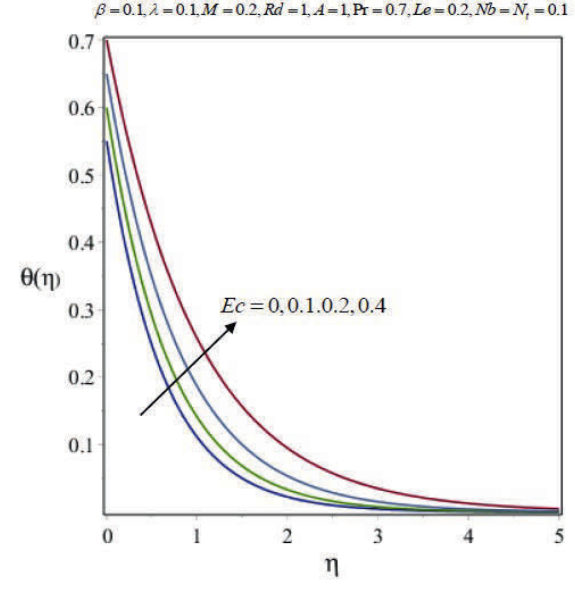
Fig. 16: Variation of temperature profile θ ( η ) with η for several val- ues of Eckert number Ec .